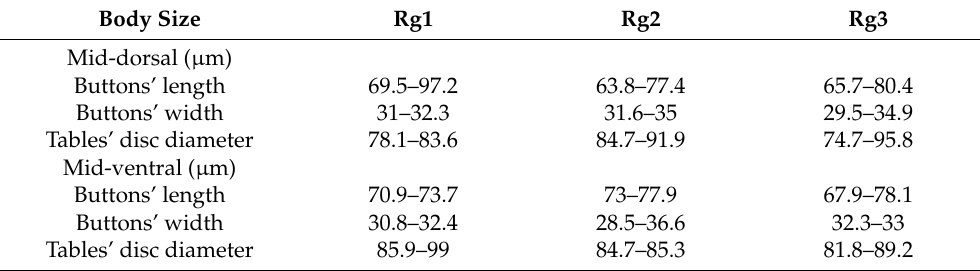
Table 1. Size range of ossicles from the middle of Holothuria impatiens ’ dorsal and ventral sides with different body sizes; Rg1 (0.5–4 cm); Rg2 (4–8 cm); Rg3 (8–12 cm).